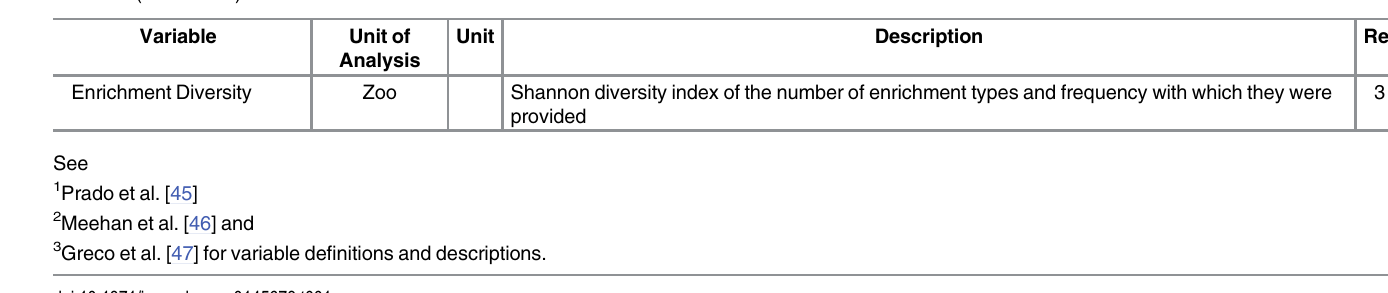
(P < 0.05) (Table 2). Additionally, more African females experienced irregular ovarian cycles than did Asian females (P < 0.05). Overall rates of abnormal cycle activity (acyclic plus irregu- lar cycles) were 26.7% for Asian and 51.6% for African elephants; a significant species differ- ence (P < 0.05). Within the study population, the youngest age that a female cycled was 15 years for Asian and 9 years for African, and the oldest age was 55 years for Asian and 54 years for African ele- phants. Reproductive cyclicity status as a function of age for both species is presented in Fig 2. Most acyclicity in post-pubertal Asian elephants was observed in females > 36 years of age; only one Asian female less than 36 years of age was not cycling. For African elephants, acycli- city was observed in females as young as 27 years of age, with the majority of acyclicity found in the 31 – 50 year age categories. Overall, African elephant females were younger than Asians (33.1 ± 0.8 years vs. 38.5 ± 1.1 years, respectively), as was the mean age of acyclic African